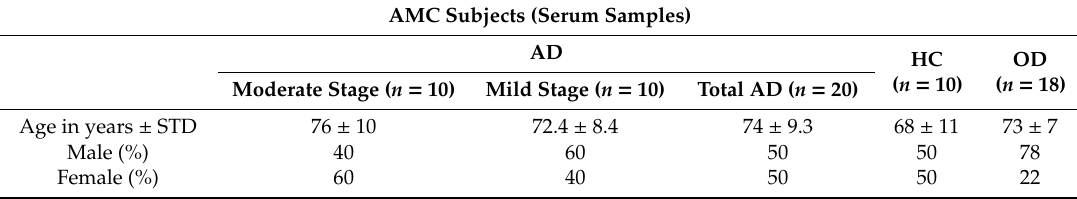
Table 1. Summary of demographic information on the blood serum study